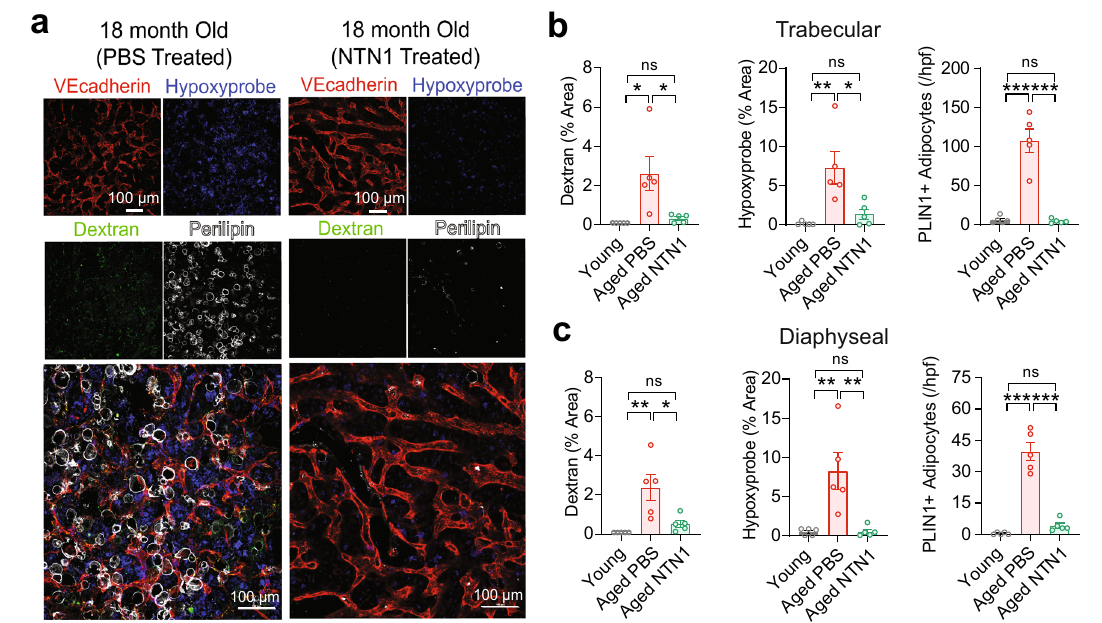
Fig. 7 | NTN1 supplementation rejuvenates the agedBM niche.a Representative immuno fl uorescence images of trabecular regions of femurs showing an improvement of aging-related BM niche defects following NTN1 treatment. b , c Analysis of BM niche function following NTN1 treatment of aged mice by determining vascular leakiness (10kDa dextran extravasation), vascular perfusion (Hypoxyprobestaining),andBMadiposity(PLIN1+adipocytes/highpower fi eld)in